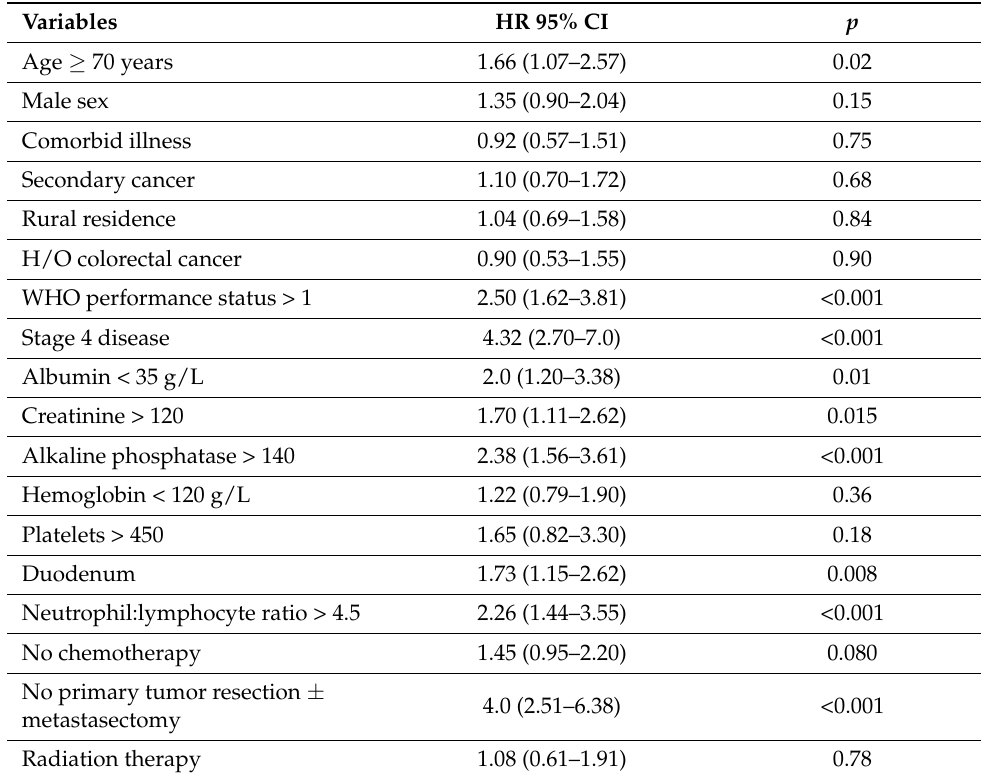
Table 2. Cox regression univariate analyses for assessment of various variables and overall survival of patients with small intestine